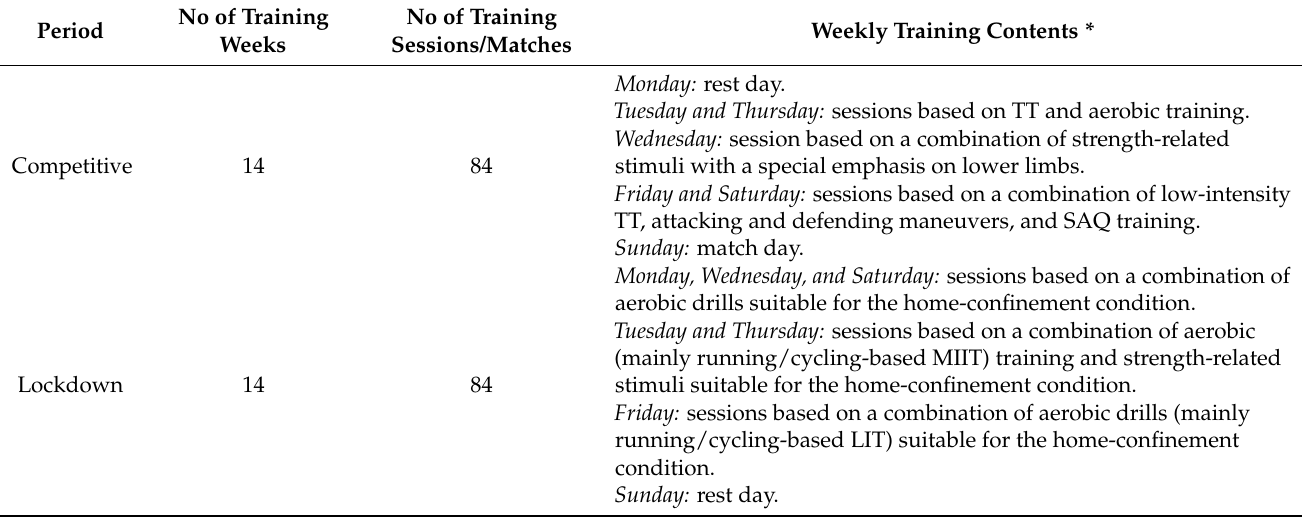
Table 1. Overview of training contents during the COVID-19 lockdown and competitive